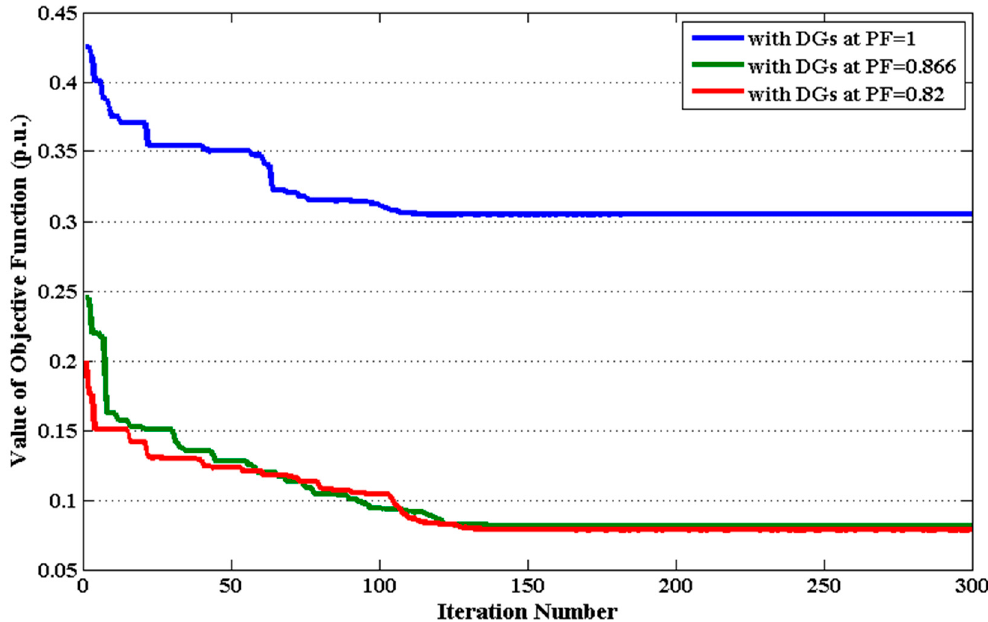
Figure 16. Convergence characteristics for Case 2 of the IEEE 118-bus system using QODELFA.